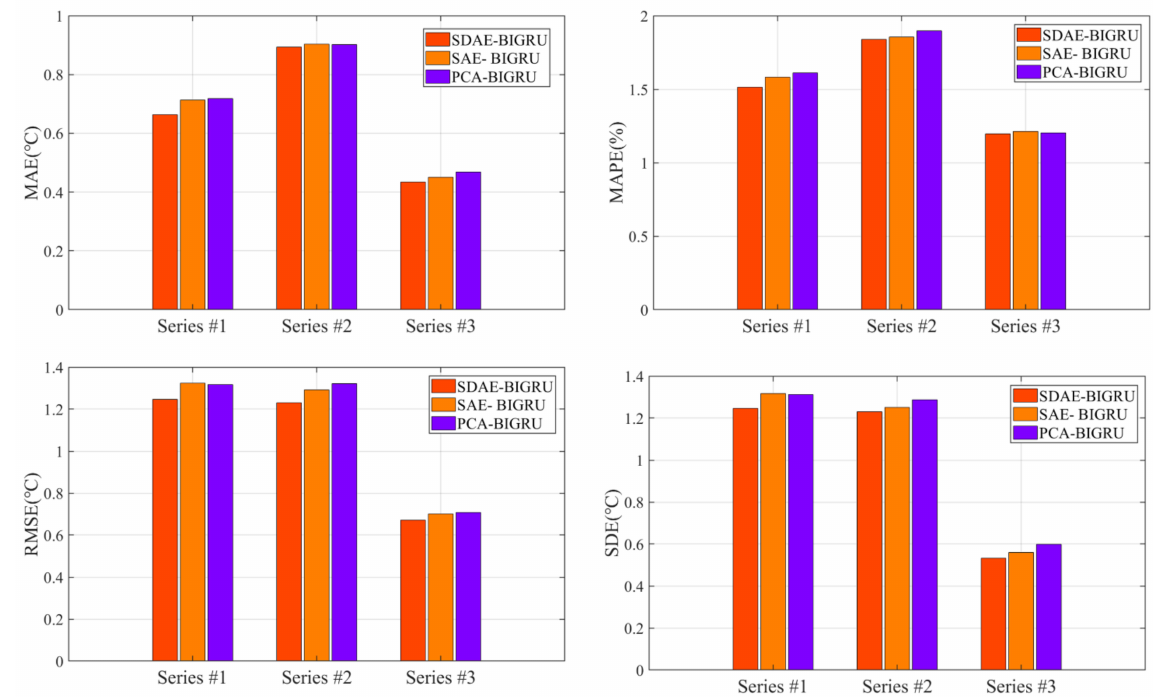
Figure 9. Forecasting performance evaluation indexes: MAE, MAPE, RMSE, and SDE values of different feature extraction